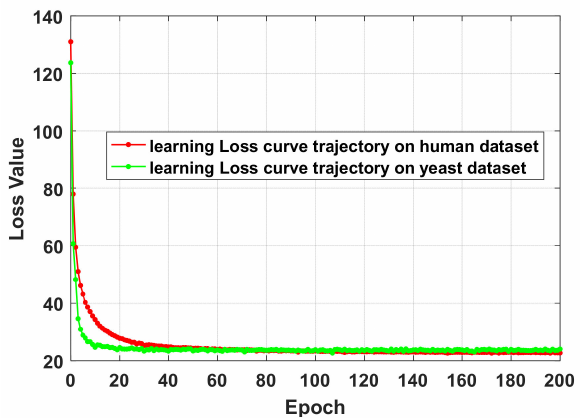
Figure 3. The ROC generated by SIPGCN in the yeast data set.